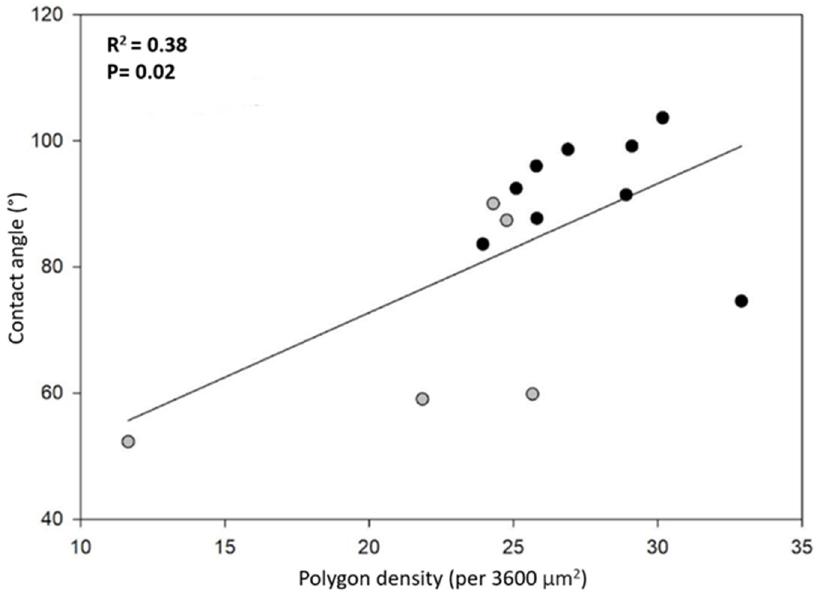
Figure 6. Correlation between contact angle and polygon density per area (3600 μ m 2 ): HMO ( gray dots ) and KB ( black dots ).